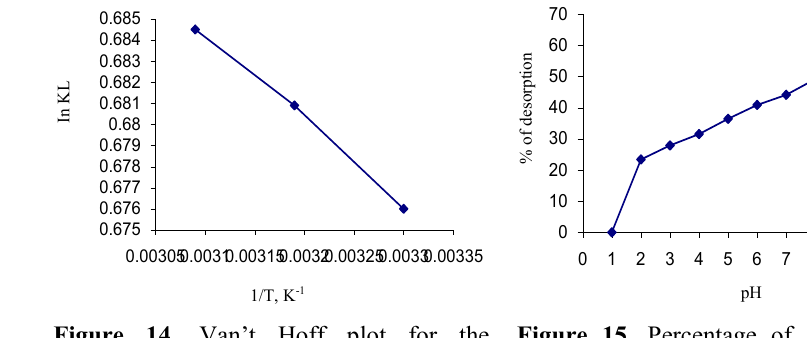
Figure 14. Van’t Hoff plot for the adsorption AG 25 on to ACC at 303, 313 and 323 K.